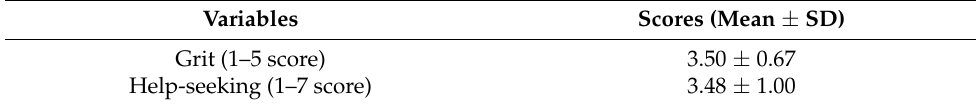
Table 3. Grit and help-seeking scores among rural Illinois veterans ≥ 18 years recruited from five food pantries from March 2021 to November 2021 1 .